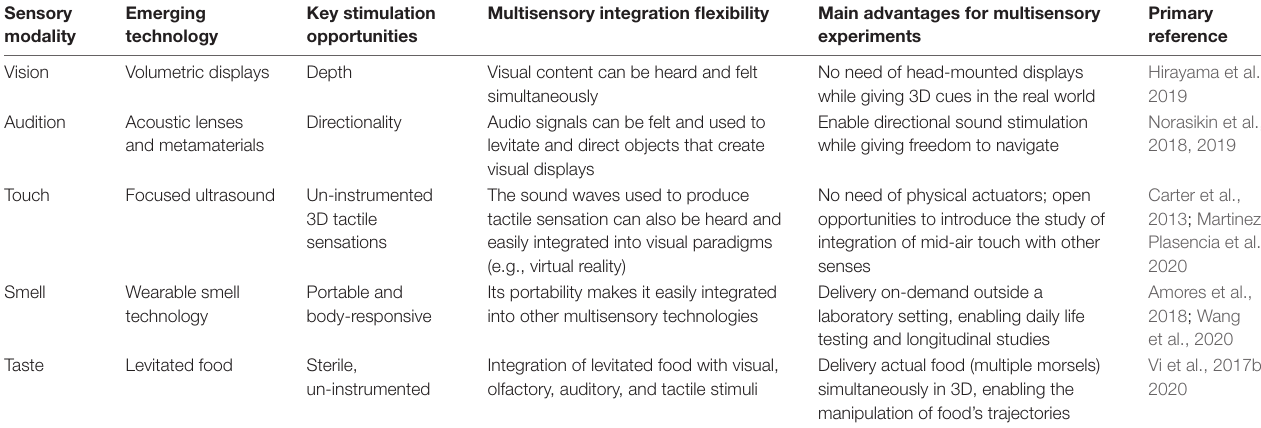
TABLE 1 | Key properties of emerging multisensory technologies for each sensory